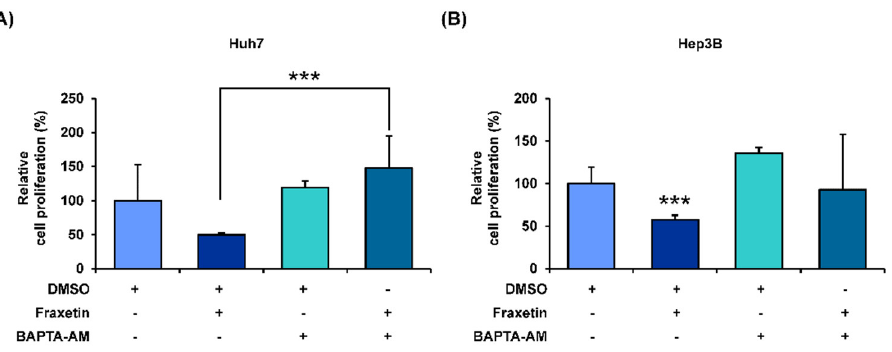
Figure 6. Regulatory effects of calcium ion on the proliferation of human HCC cells. ( A , B ) Relative proliferation of Huh7 ( A ) and Hep3B ( B ) cells treated with fraxetin and with or without BAPTA-AM for 48 h. Asterisks indicate the significance levels of comparisons between the vehicle and fraxetin with BAPTA treatments (*** p < 0.001).